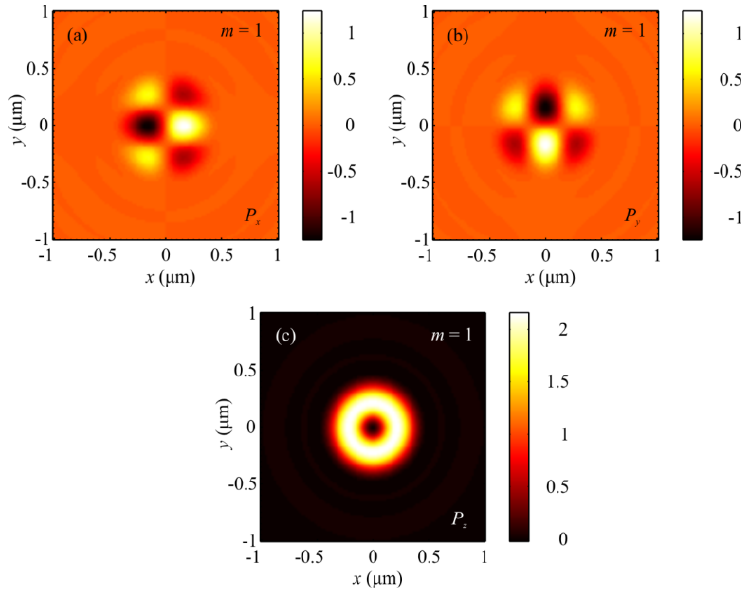
Figure 2. Patterns of the Poynting vector components ( a ) P x , ( b ) P y , and ( c ) P z in the focal plane when focusing a plane wave with the hybrid polarization of Equation (1) at m = 1.